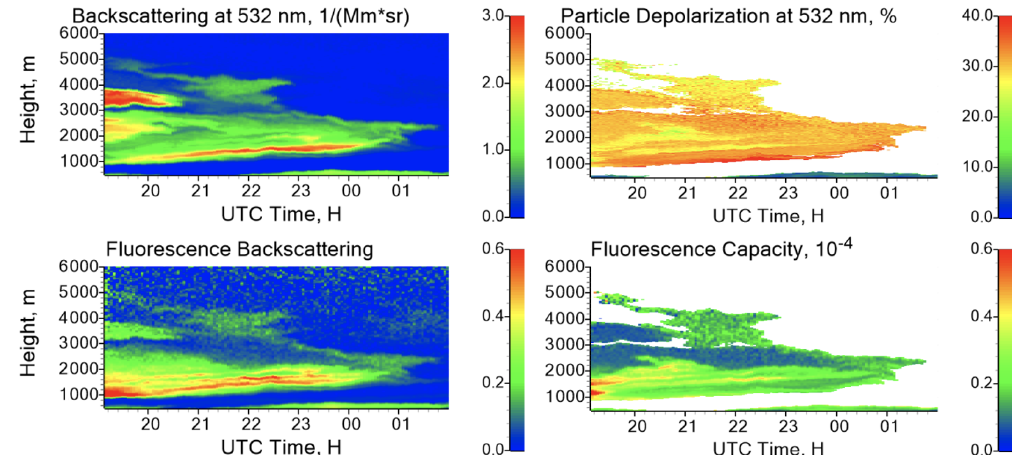
Figure 17. Height–temporal distributions of the backscattering coefficient at 532nm β 532 , the fluorescence backscattering coefficient β F (in 10 − 4 Mm − 1 sr − 1 ), the particle depolarization ratio at 532nm δ 532 , and the fluorescence capacity G F on the night of 1–2 April 2021. The values of δ 532 and G F are shown for β 532 > 0.3Mm − 1 sr − 1 .